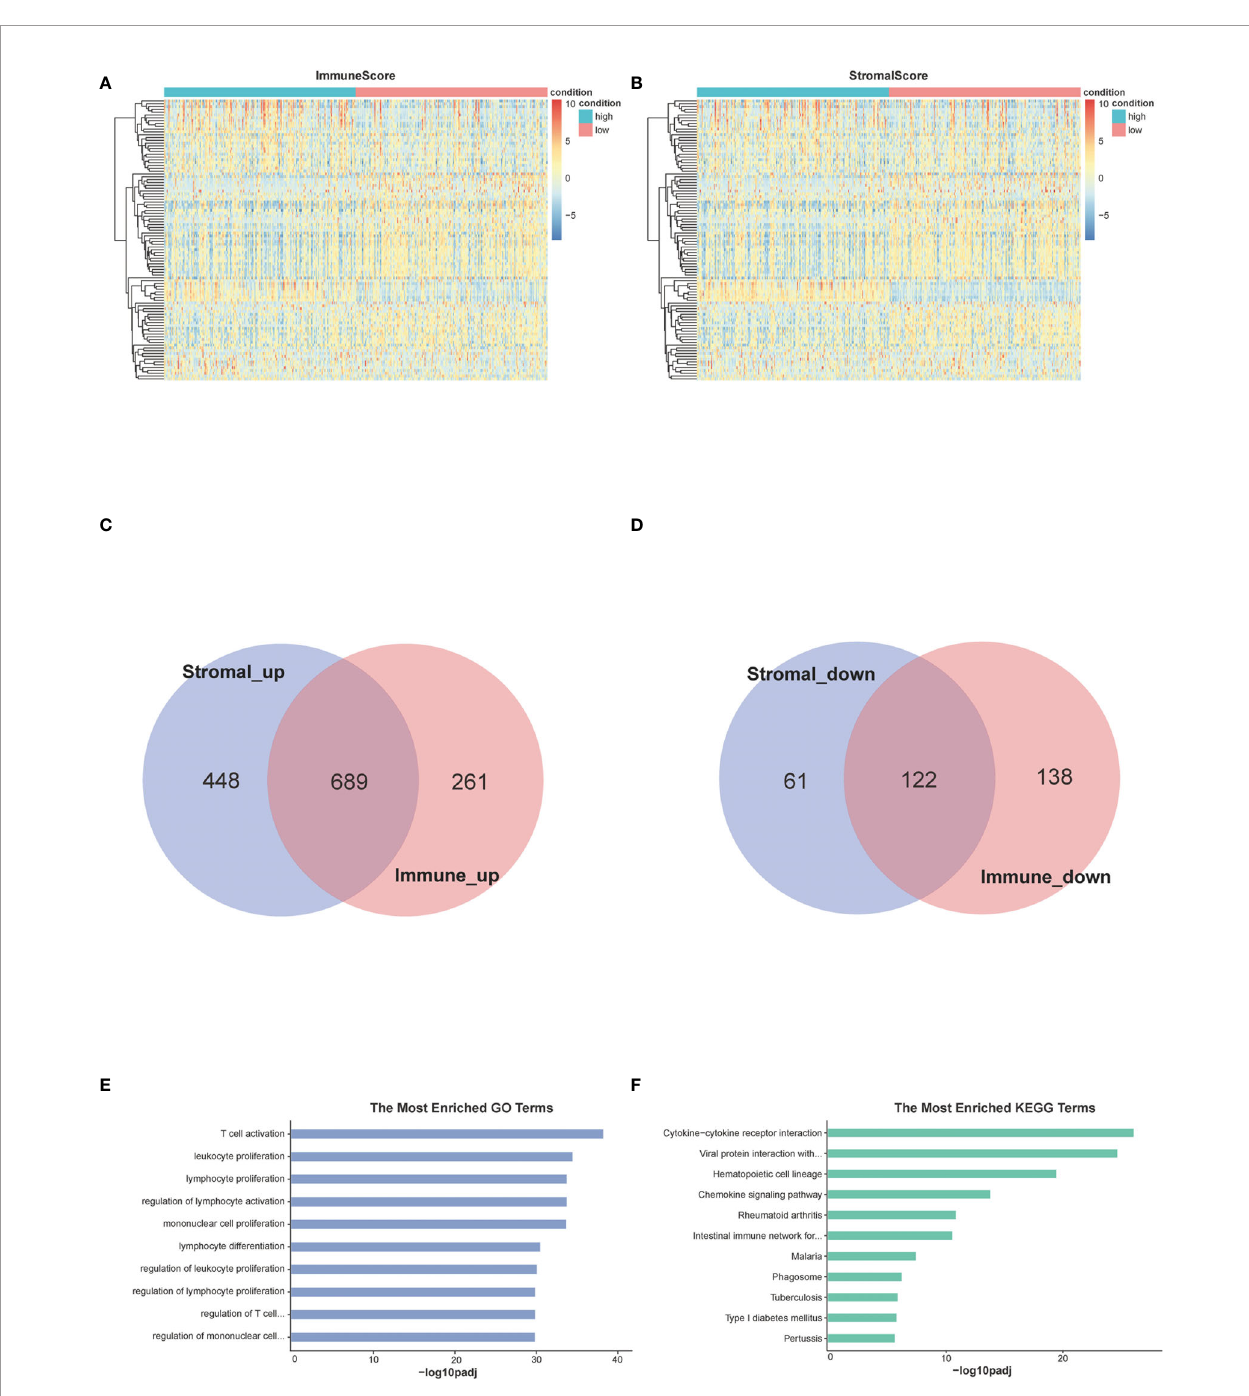
FIGURE 2 | Heatmaps, Venn plots, and enrichment analysis of GO and KEGG for DEGs. (A, B) Heatmap for DEGs generated by comparison of the high score group vs. the low score group in StromalScore and ImmuneScore. Row is the gene, and column name is the samples which not shown in plot. Differentially expressed genes were determined by Wilcoxon rank sum test with q < 0.05 and log2foldchange >1.5 as the signi fi cance threshold. (C, D) Venn plots showing common up-regulated and down-regulated DEGs shared by StromalScore and ImmuneScore. (E, F) GO and KEGG enrichment analysis for 811 DEGs, terms with p and q < 0.05 were considered signi fi